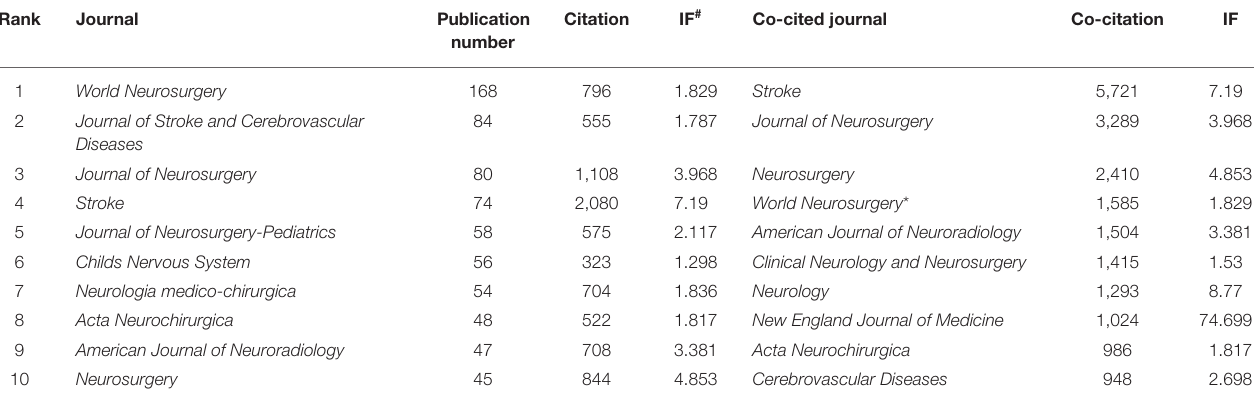
TABLE 3 | The top 10 journals and co-cited journals on MMA research between 2010 and 2019.